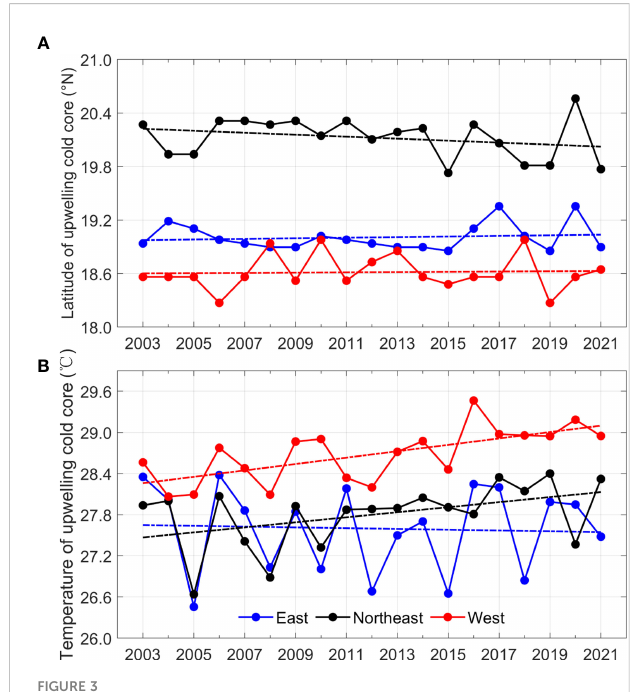
FIGURE 3 Interannual variations of the latitude (A) and water temperature (B) of the upwelling cold core on the east, northeast and west sides of Hainan Island. The dashed line represents the linear trend of each